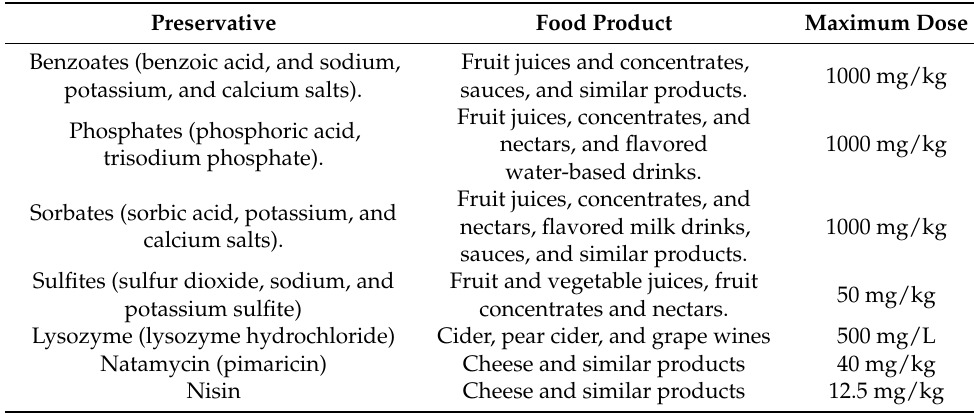
Table 2. Maximum doses of some preservatives commonly used in the food industry. Preservative Food Product Maximum Dose Benzoates (benzoic acid, and sodium, Fruit juices and concentrates, 1000 mg/kg potassium, and calcium salts). sauces, and similar products. Fruit juices, concentrates, and Phosphates (phosphoric acid, nectars, and flavored 1000 mg/kg trisodium phosphate). water-based drinks. Fruit juices, concentrates, and Sorbates (sorbic acid, potassium, and nectars, flavored milk drinks, 1000 mg/kg calcium salts). sauces, and similar products. Sulfites (sulfur dioxide, sodium, and Fruit and vegetable juices, fruit 50 mg/kg potassium sulfite) concentrates and nectars. Lysozyme (lysozyme hydrochloride) Cider, pear cider, and grape wines 500 mg/L Natamycin (pimaricin) Cheese and similar products 40 mg/kg Nisin Cheese and similar products 12.5 mg/kg Source: FAO